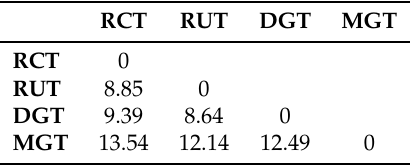
Table 3. Mean values of absolute differences of SVO scores between treatments. RCT RUT